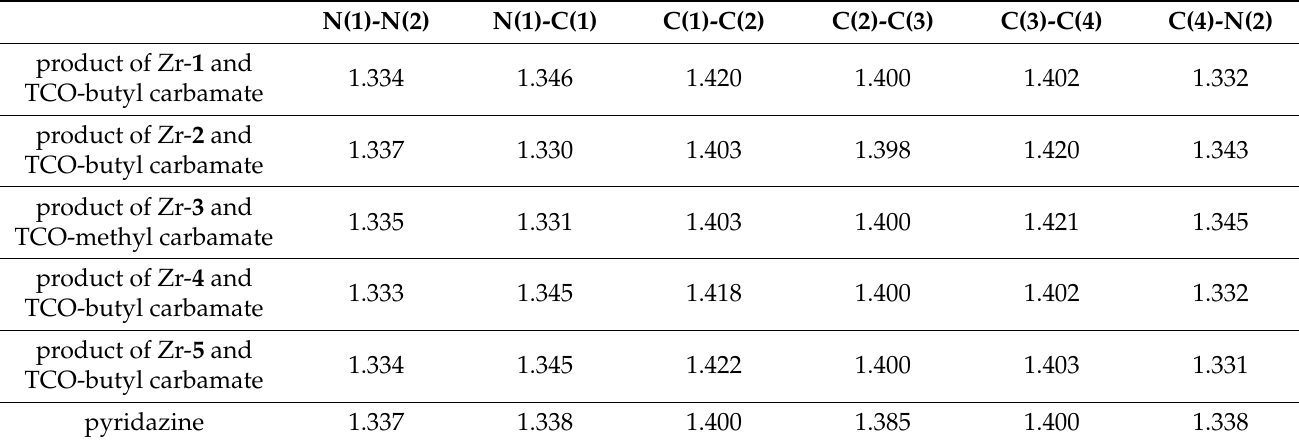
Table 2. Bond lengths in the formed heterocycles obtained by DFT calculations, as well as the literature data for free pyridazine [33] given for comparison. All values are given in